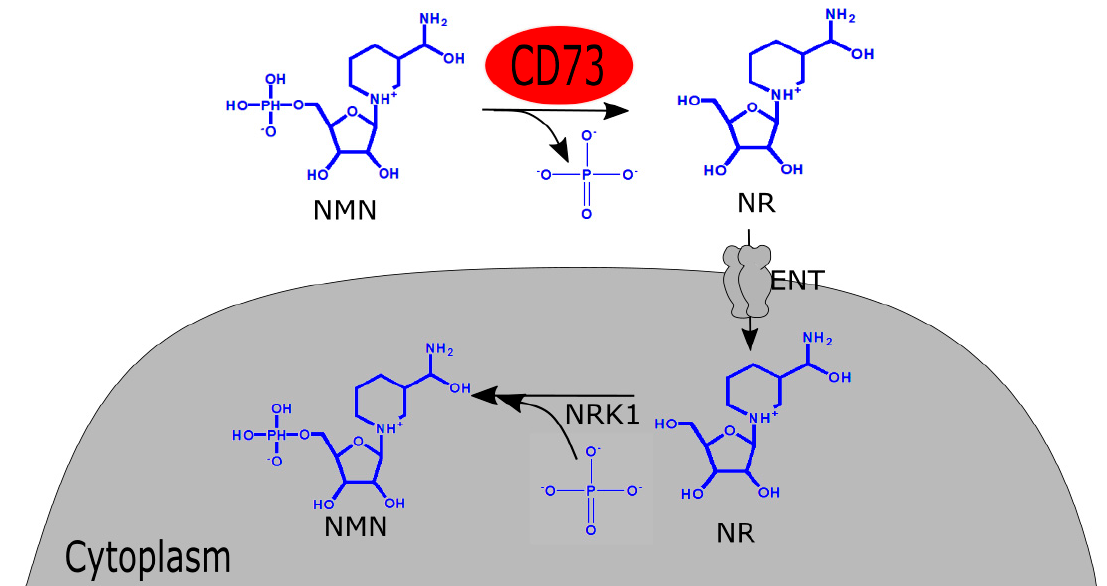
Figure 2. Schematic of absorption of NMN in mammalian cells. NMN: nicotinamide mononucleotide; NR: nicotinamide riboside; NRK 1: nicotinamide riboside kinase 1; ENT: Equilibrative nucleoside transporters.